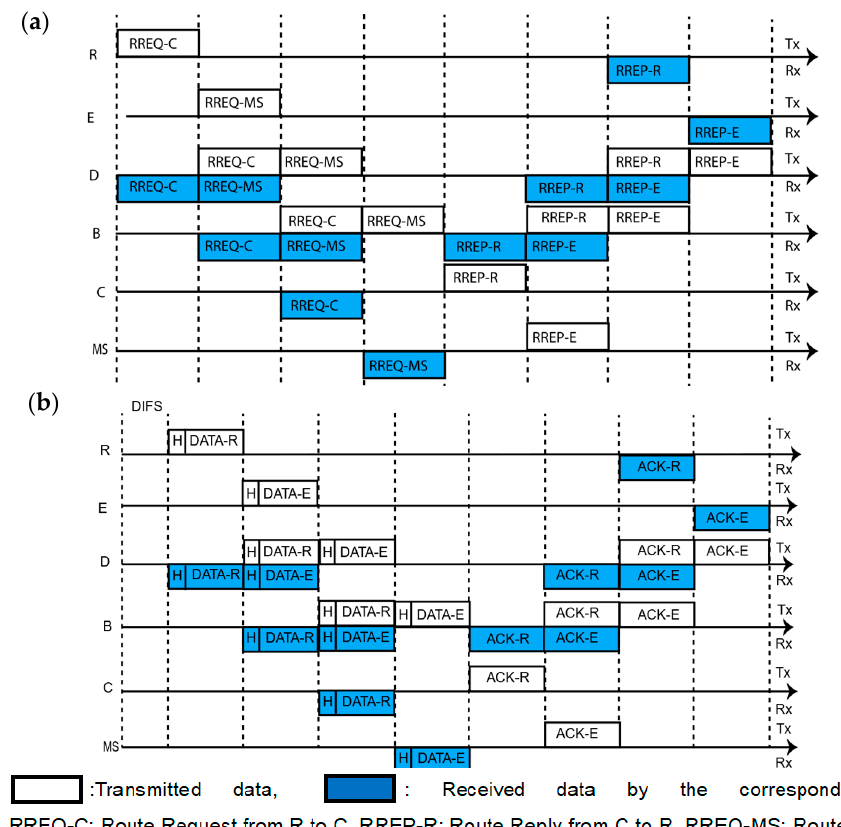
Figure 4. FD data transmission when transmitter and receiver nodes are out of the range between each other; ( a ) route selection process; ( b ) data transmission process.